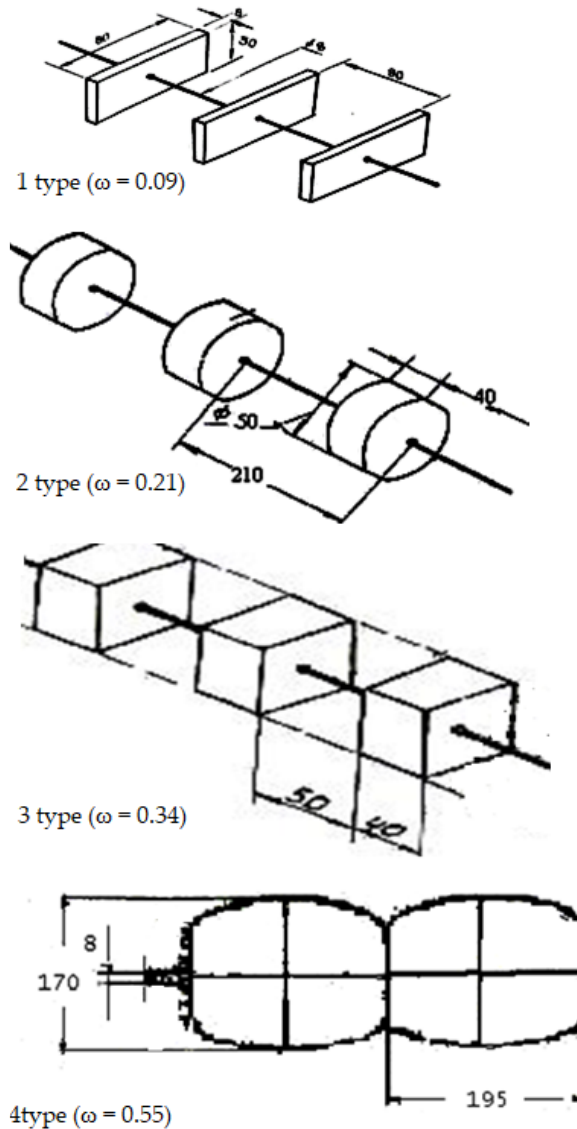
Figure A1. Photo dated 16 November 2020.